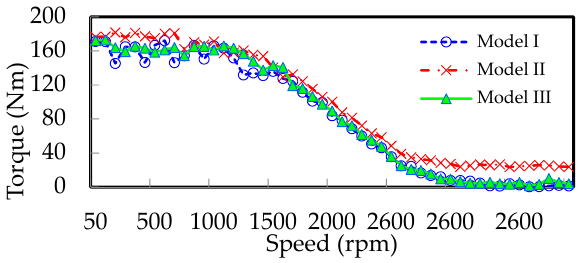
Figure 15. Torque-speed characteristic in different models when the torque command T e * = 200 nm.